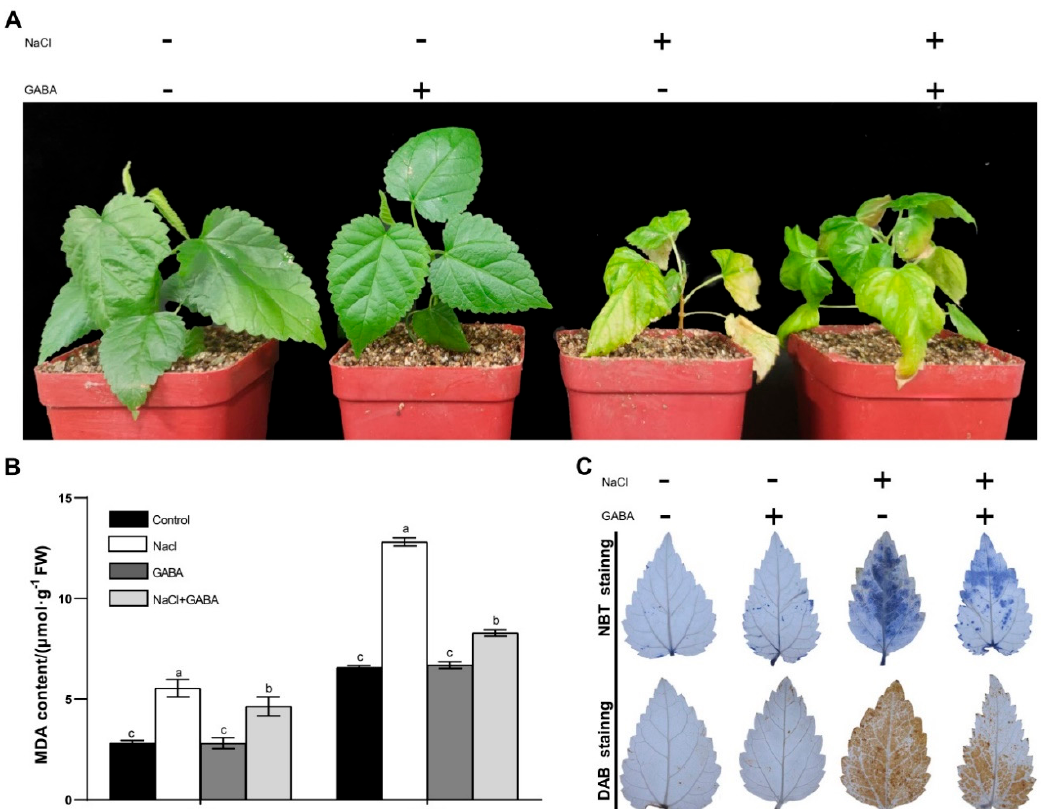
Figure 1. Exogenous application of gamma ‐ aminobutyric acid (GABA) conferred increased toler